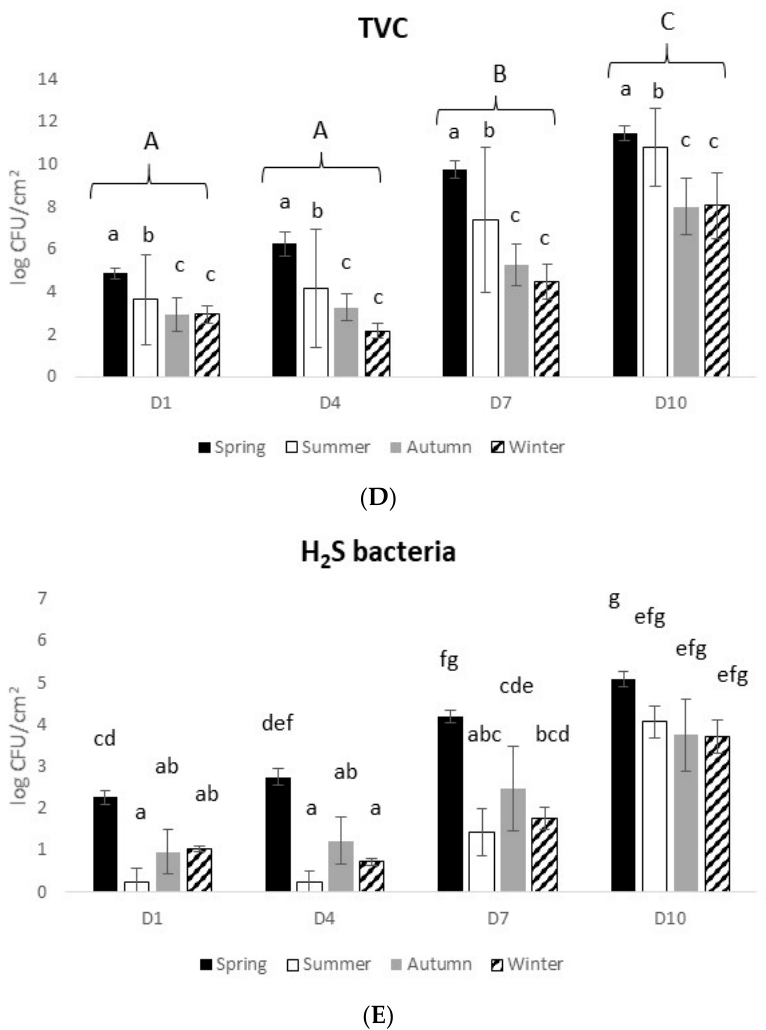
Figure 1. Seasonal gilthead seabream freshness profile over 10 days on ice, assessed by different methods: ( A ) Quality Index Method, ( B ) EC scheme, ( C ) Torrymeter (TRM), ( D ) microbiology (TVC), and ( E ) microbiology (H 2 S-producing bacteria). Values represent mean ± SD ( n = 6). In Figure 1D, different uppercase letters indicate significant differences among days, while different lowercase letters indicate significant differences among seasons. In the other figures, different letters indicate significant differences among treatments.